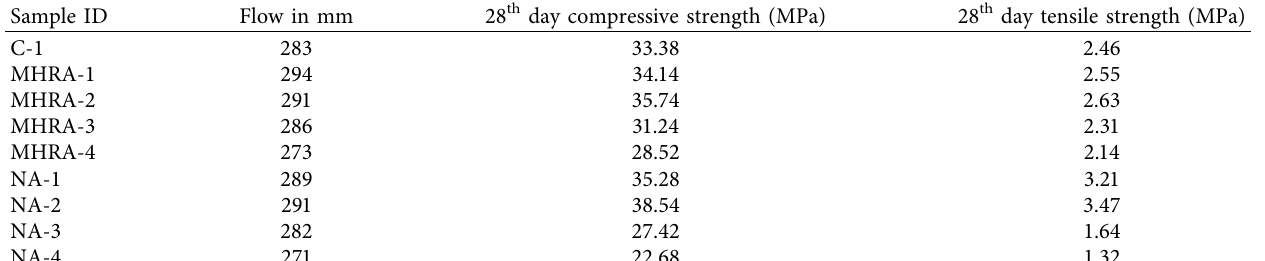
Figure 6: XRDE patterns of α -phase nano Al Table 2: Flowability and ultimate strength.